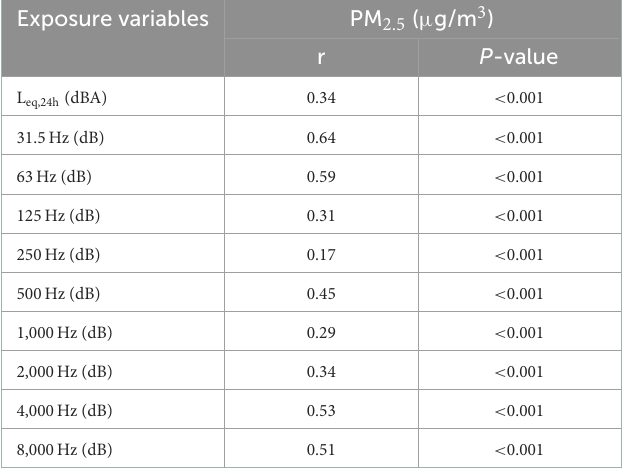
TABLE 3 Correlations between the annual 24h road traffic noise and fine particles. Exposure